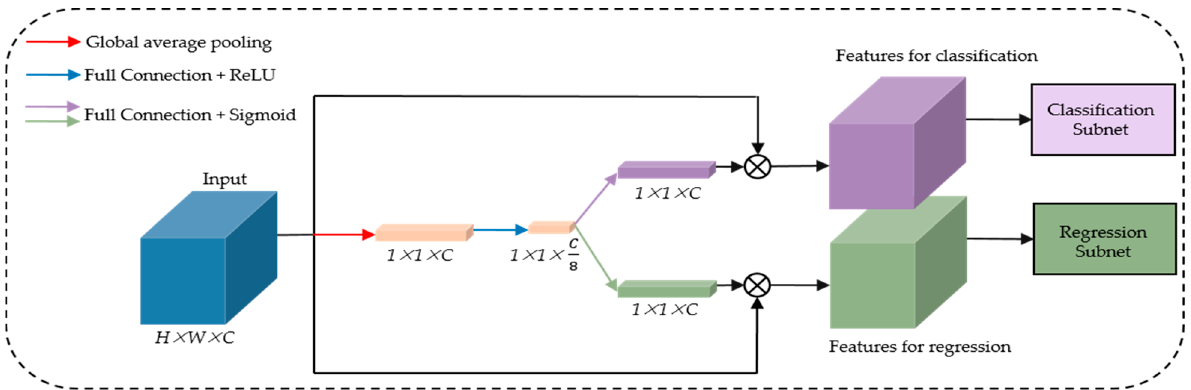
Figure 9. Architecture of rotational detection network